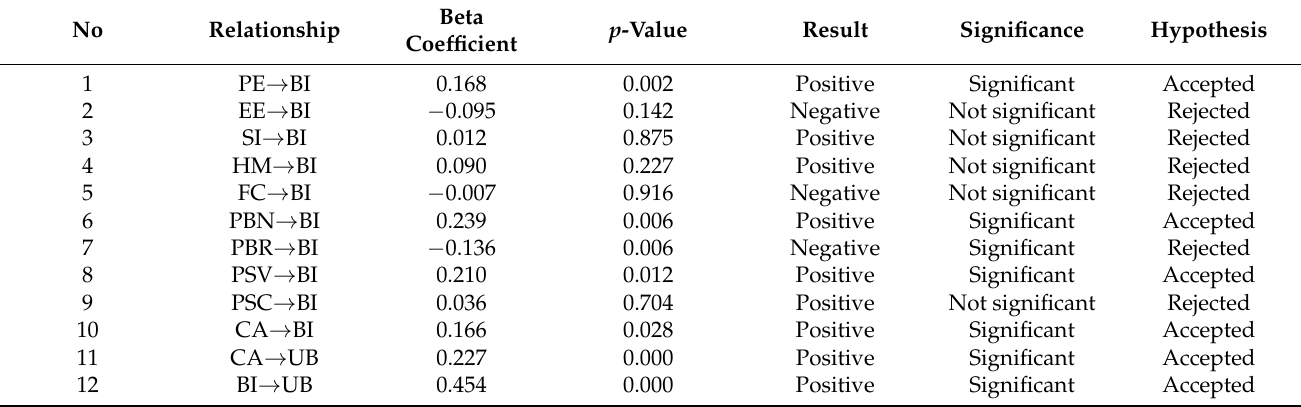
Figure 3. The SEM for determining the factors affecting the intention to use online grocery apps. Table 5. The reliability and convergent validity results. The PLS-SEM was performed to test the proposed hypotheses using Smart PLS v3.3.3. The results are shown in Table 6. It could be seen that usage behavior was significantly influenced by behavioral intentions ( β = 0.454, p = 0.000) and cues to action ( β = 0.227, p = 0.000). Moreover, the factors that positively influence the behavioral intentions to use online grocery apps are performance expectancy ( β = 0.168, p = 0.002), perceived benefits ( β = 0.239, p = 0.006), cues to action ( β = 0.166, p = 0.028), and perceived severity ( β = 0.210, p = 0.012). On the contrary, perceived barriers are found to have a negative influence on behavioral intentions ( β = − 0.136, p = 0.006). Table 6. The respondents’ hypothesis